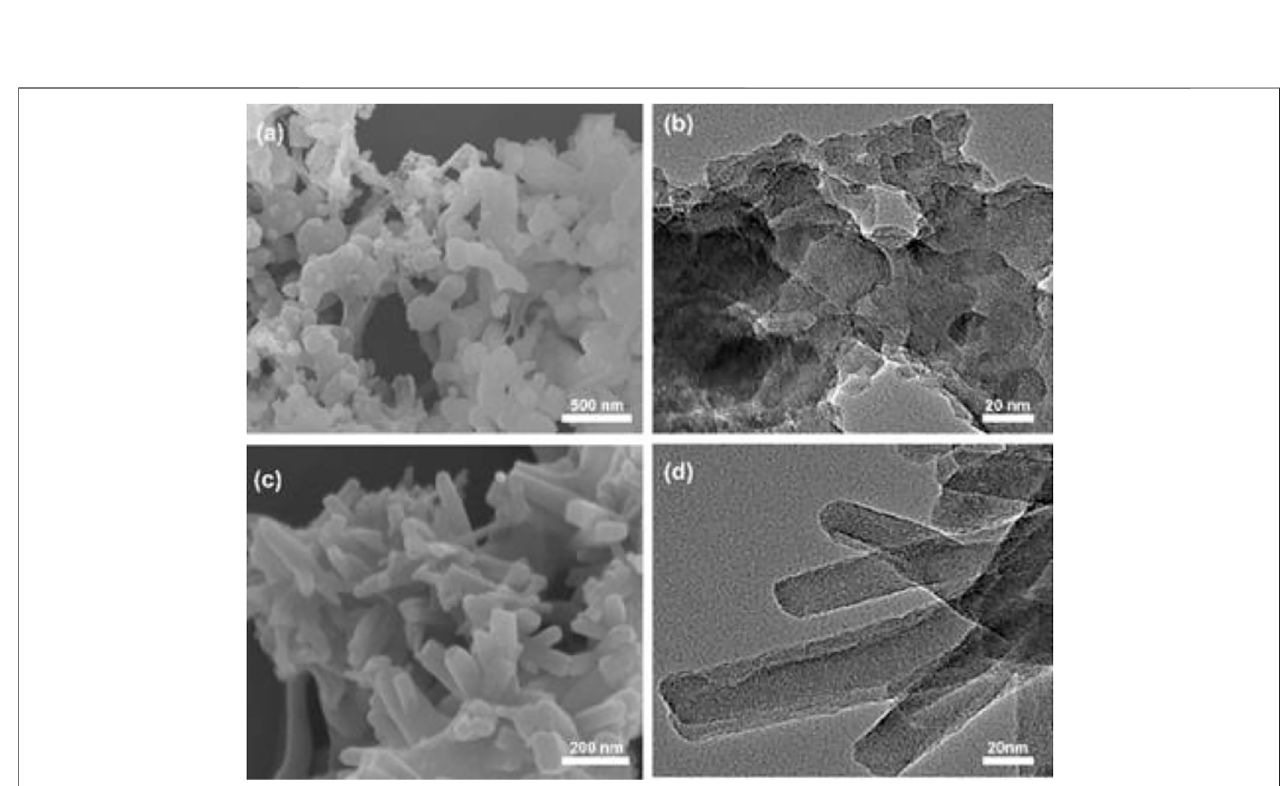
FIGURE 1 | (A) SEM image of TrPB-CMP, (B) TEM image of TrPB-CMP, (C) SEM image of TePB-CMP and (D) TEM image of TePB-CMP.